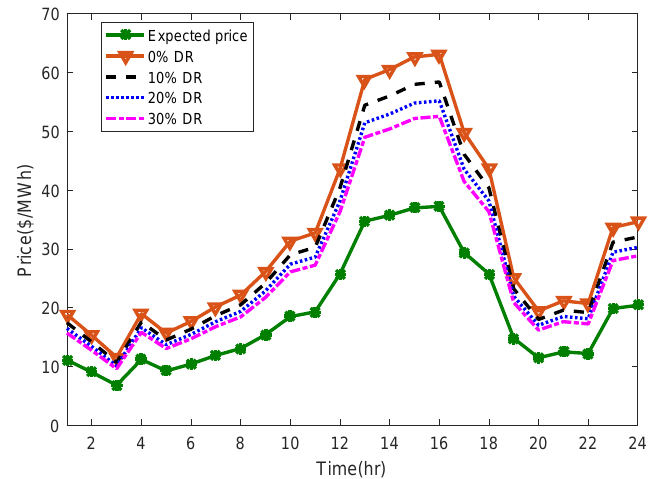
Figure 9. The effect of demand response on real-time